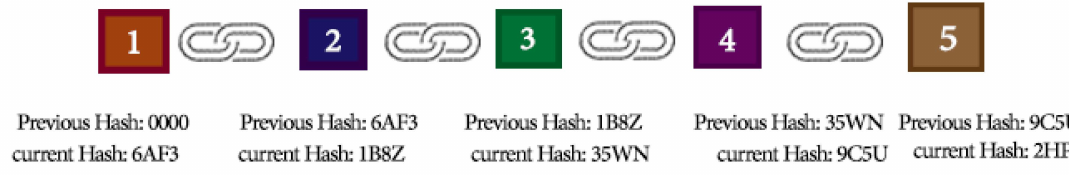
Figure 8. In a typical WSN, a blockchain planning instance for preferential